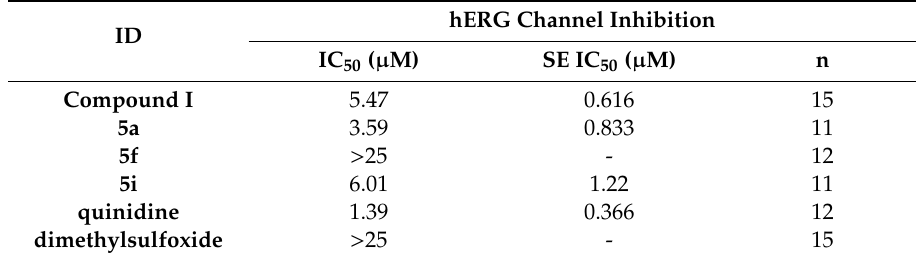
Table 4. In vitro cardiotoxicity expressed in terms of IC 50 of hERG channel inhibition of diarylethylamine compounds ( 5a , 5f , 5i ) compared to control compounds (quinidine